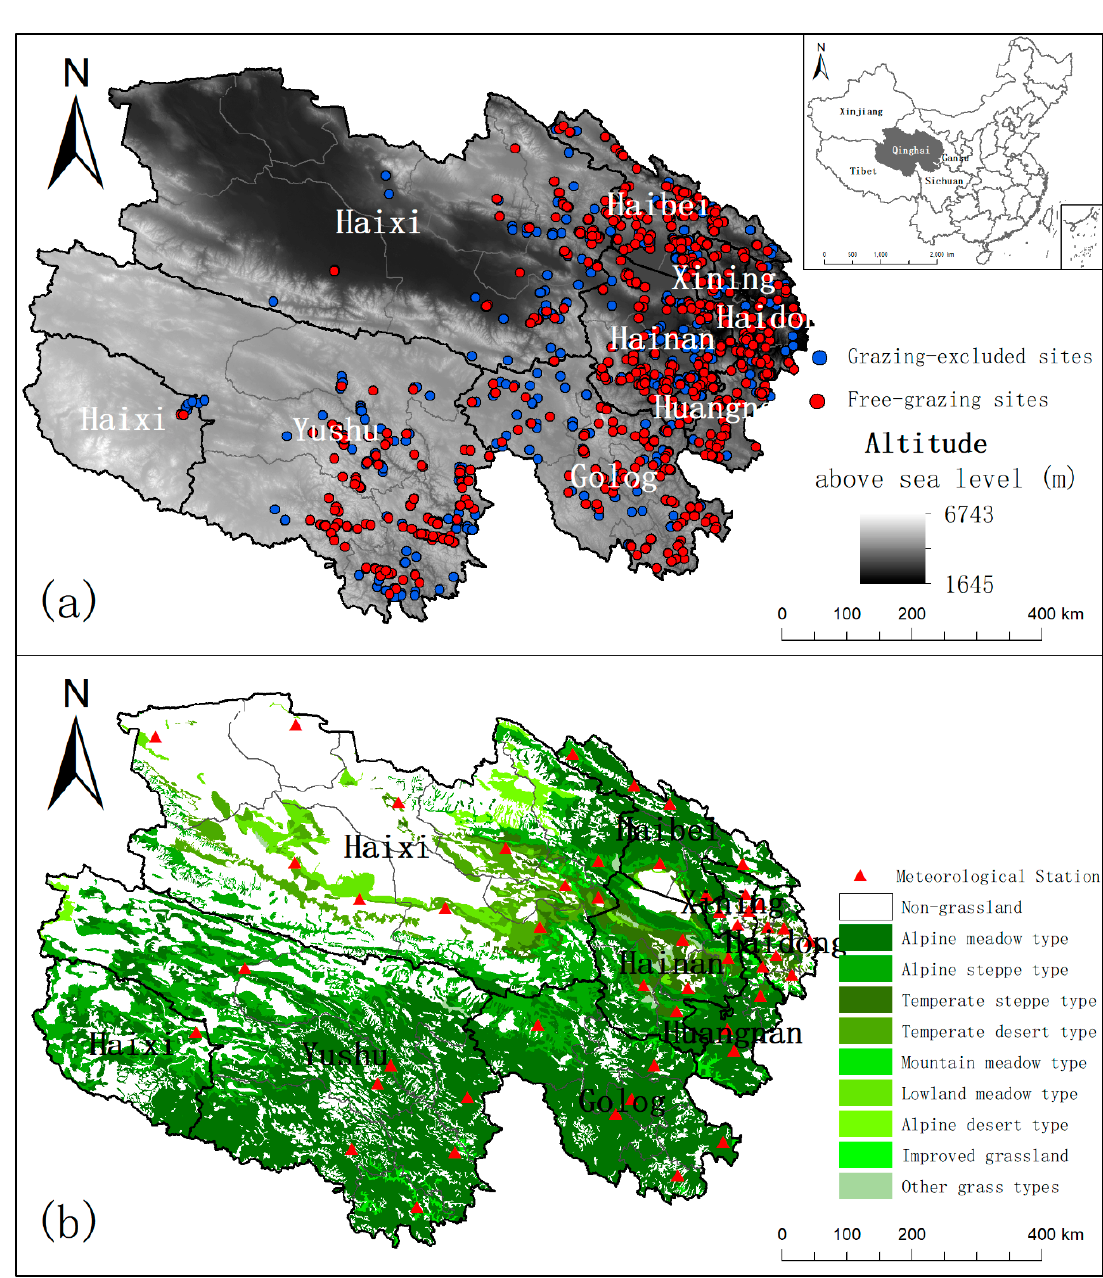
Figure 1. Study area: ( a ) altitude above sea level (http://srtm.csi.cgiar.org/, accessed on 1 November 2019) and verification sites location (grazing-excluded sites in blue, free-grazing sites in red); ( b ) alpine grassland types [24] and meteorological station location.